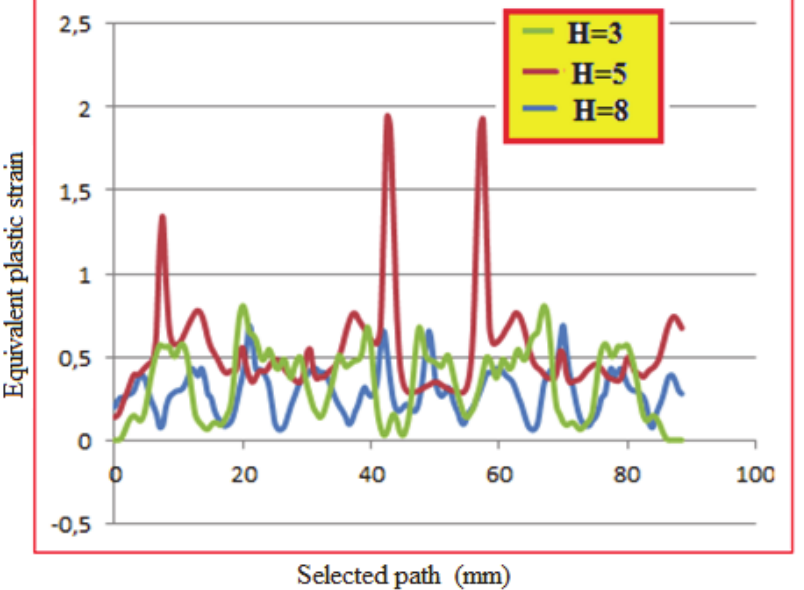
Figure 18: Evolution of the equivalent plastic deformation along a path on the upper surface, using different groove